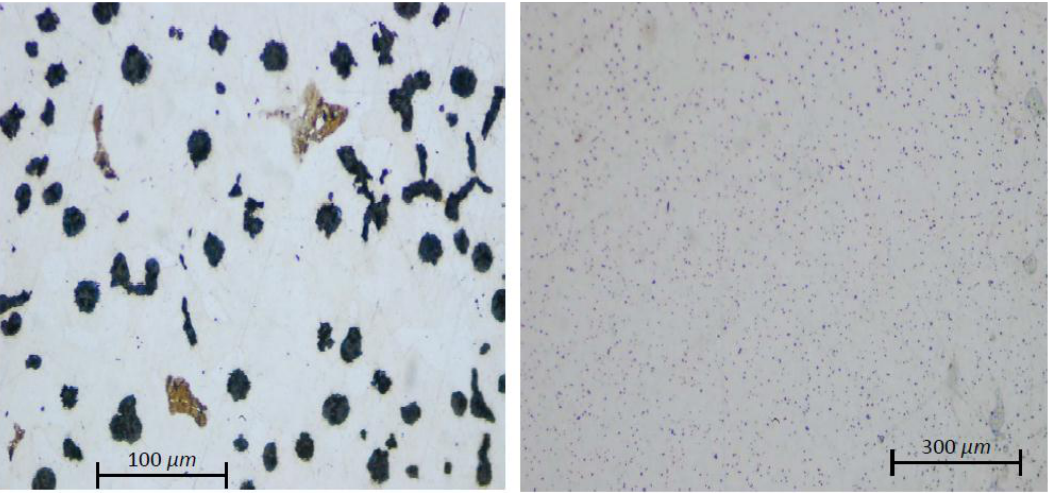
Figure 8. Micrographs of ductile iron showing the distribution of the nodules on the weld after annealing at 900 °C.